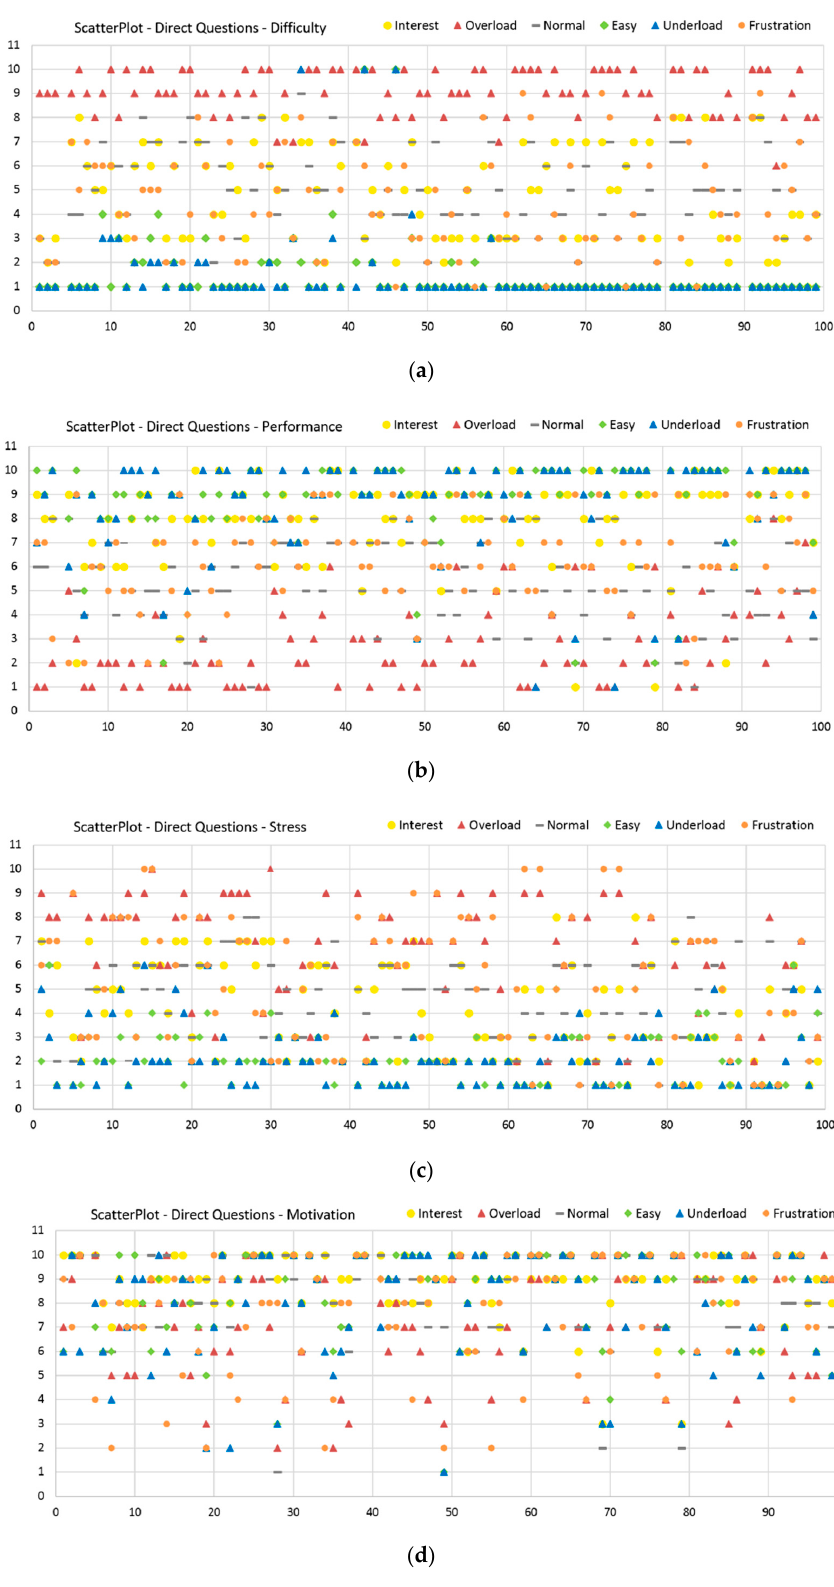
Figure A2. ( a ) Ratings distribution of the “Di ffi culty” question for all the measurements. ( b ) Ratings distribution of the “Performance” question for all the measurements. ( c ) Ratings distribution of the “Stress” question for all the measurements. ( d ) Ratings distribution of the “Motivation” question for all the